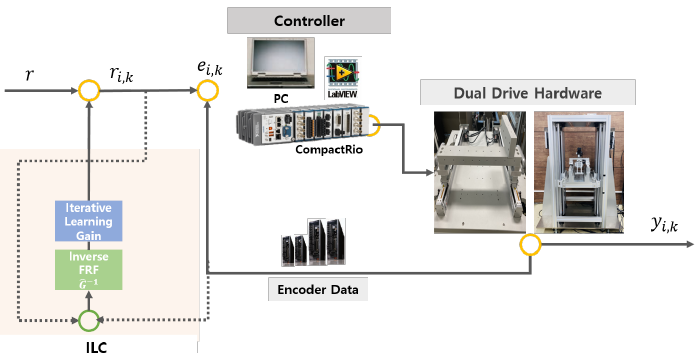
Figure 7. Control system